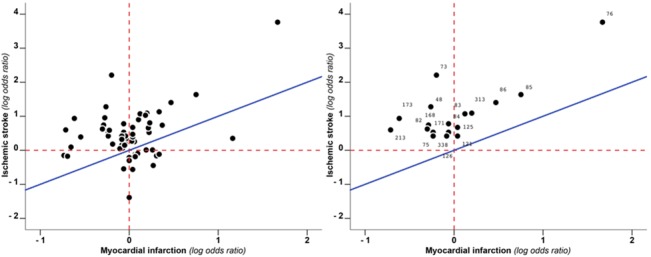
Prothrombotic risk factors with RRR either >1+SE and <1-SE (left) and either > 1+SE and <1-SE (right).Each point depicts the log odds ratio as a measure of effect of a particular risk factor on the risk of myocardial infarction (x-axis) as well as the effect on the risk of ischaemic stroke (y-axis). The red dashed lines indicate the null effect for either myocardial infarction (vertical line) or ischaemic stroke (horizontal line). The blue diagonal line represents the theoretical line along which all points would cluster when the role of thrombotic factors is similar in the aetiology of myocardial infarction and ischaemic stroke. On the left are depicted RRR>1+SE and RRR<1-SE. on the right RRR>1+2SE. No factors had RRR<1-2SE. Numbers represent the ID of the corresponding marker in Table 1 and S2, S3 and S4 Tables.